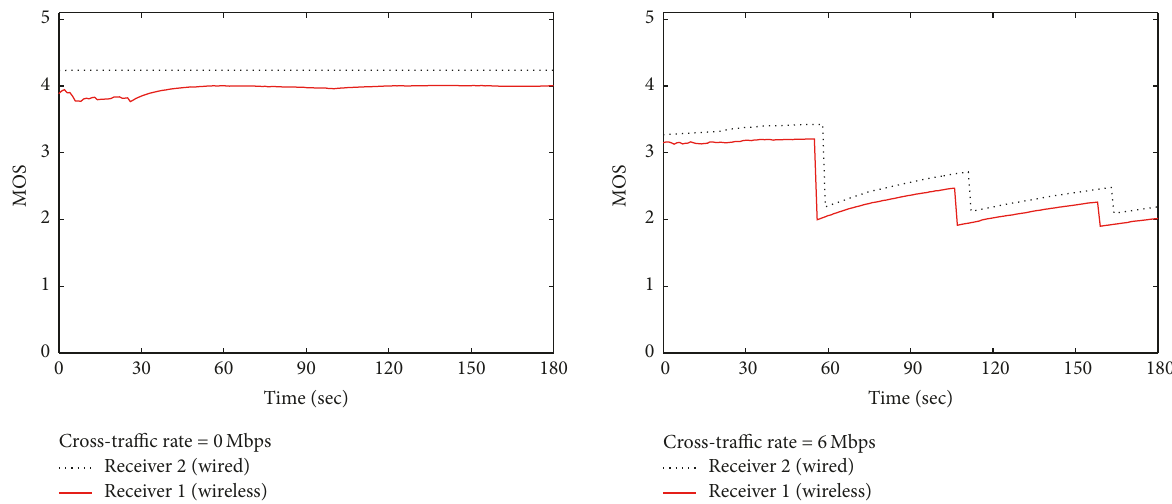
Figure 13: Comparison of QoEs of streaming services between wired and wireless receivers under different cross-traffic rates.